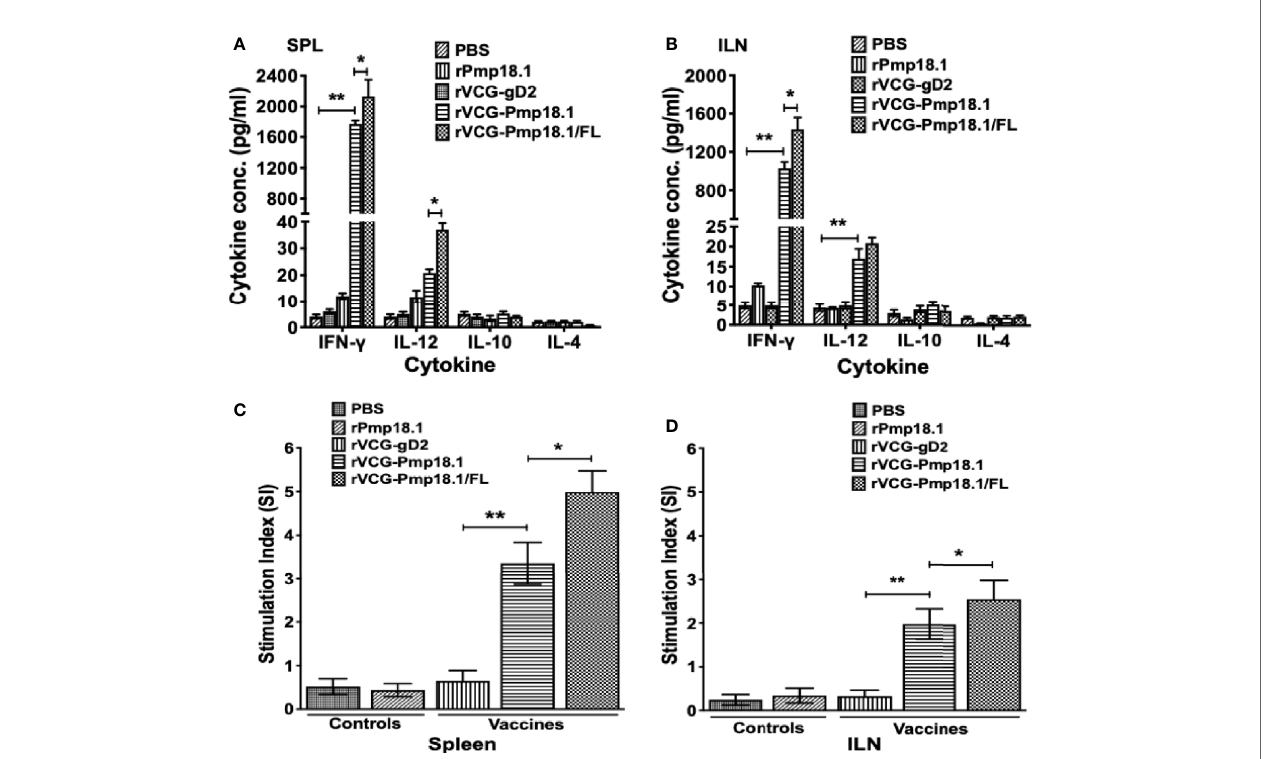
FIGURE 2 | Antigen-speci fi c genital mucosal and systemic cytokine and proliferative responses. T cells puri fi ed from the SPL and ILNs of immunized mice and controls 4 weeks postimmunization, were restimulated in vitro with 5 m g/ml of rPmp18.1 for 72 h. Control cultures contained APCs and T cells without antigen. The concentration of Th1/Th2 cytokines in the spleen, SPL (A) and ILN (B) contained in supernatants of culture-stimulated cells was measured using the Bio-Plex cytokine assay kit. All assays were performed in quadruplicate and were repeated for validation. Data were calculated as the mean values (± S.D.) for quadruplicate cultures for each experiment. The cultures without antigen did not contain detectable levels of cytokine and so the data were excluded from the results. The data shown is a representative of two assays with similar results. The antigen-speci fi c proliferative responses in the SPL (C) and ILN (D) were determined 4 weeks after the last immunization using the BrdU cell proliferation assay kit. BrdU incorporation was detected by addition of anti-BrdU antibody, and the absorbance was read at 405 nm. The experiment was repeated twice for con fi rmation. The results are expressed as the stimulation index (SI), the ratio between absorbance values of stimulated and non-stimulated cells and the bars represent the mean and S.D. of six replicates from two independent experiments. Signi fi cant differences between groups were evaluated by One-way ANOVA with Tukey ’ s post multiple comparison test at p * < 0.05 and p ** <